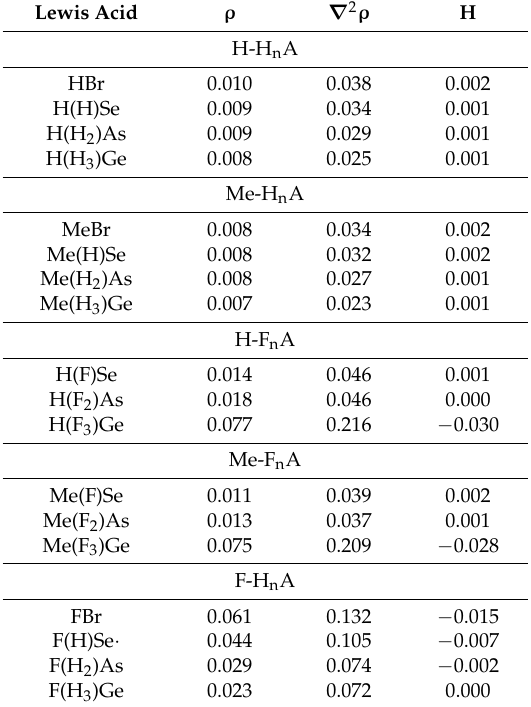
Table 3. Electron density ( ρ ), Laplacian ( ∇ 2 ρ ), and energy density (H) at the intermolecular BCP in the complexes (all are in au).